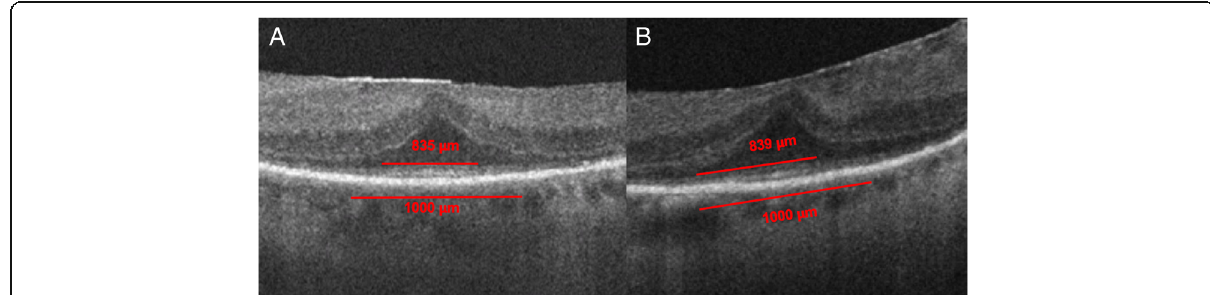
Fig. 6 SD-OCT of patient with npAIR (patient 4) showing subfoveal preservation of outer retinal elements with loss of ONL and EZ outside the fovea. A mild, globally adherent epiretinal membrane is present without intraretinal fluid, subretinal fluid, or distortion of the outer retina. a Baseline measurement of EZ horizontal extent of 835 μ m on SD-OCT of the right eye. b Follow-up measurement of the subfoveal EZ extent of 839 μ m demonstrating subtle regeneration of the EZ on SD-OCT of the right eye at most recent follow-up